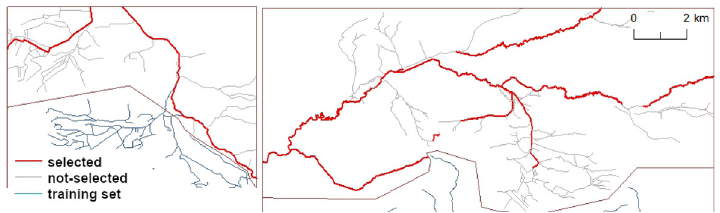
Fig. 8. Results for watercourse sections obtained by the DRST method: on the left − the Chocianów area, on the right − the Sieniawa area; the selected objects are marked in red (source: A. Fiedukowicz 2017)